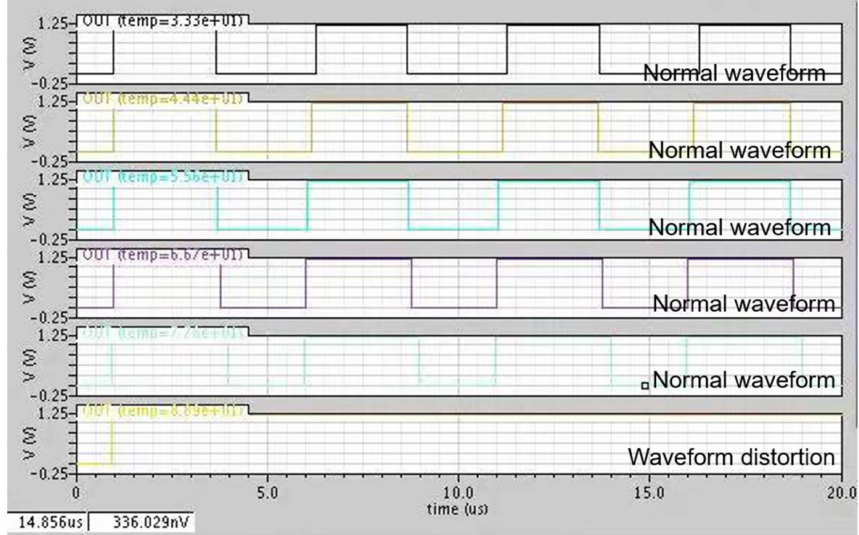
Figure 14. Comparison of output at different temperatures.